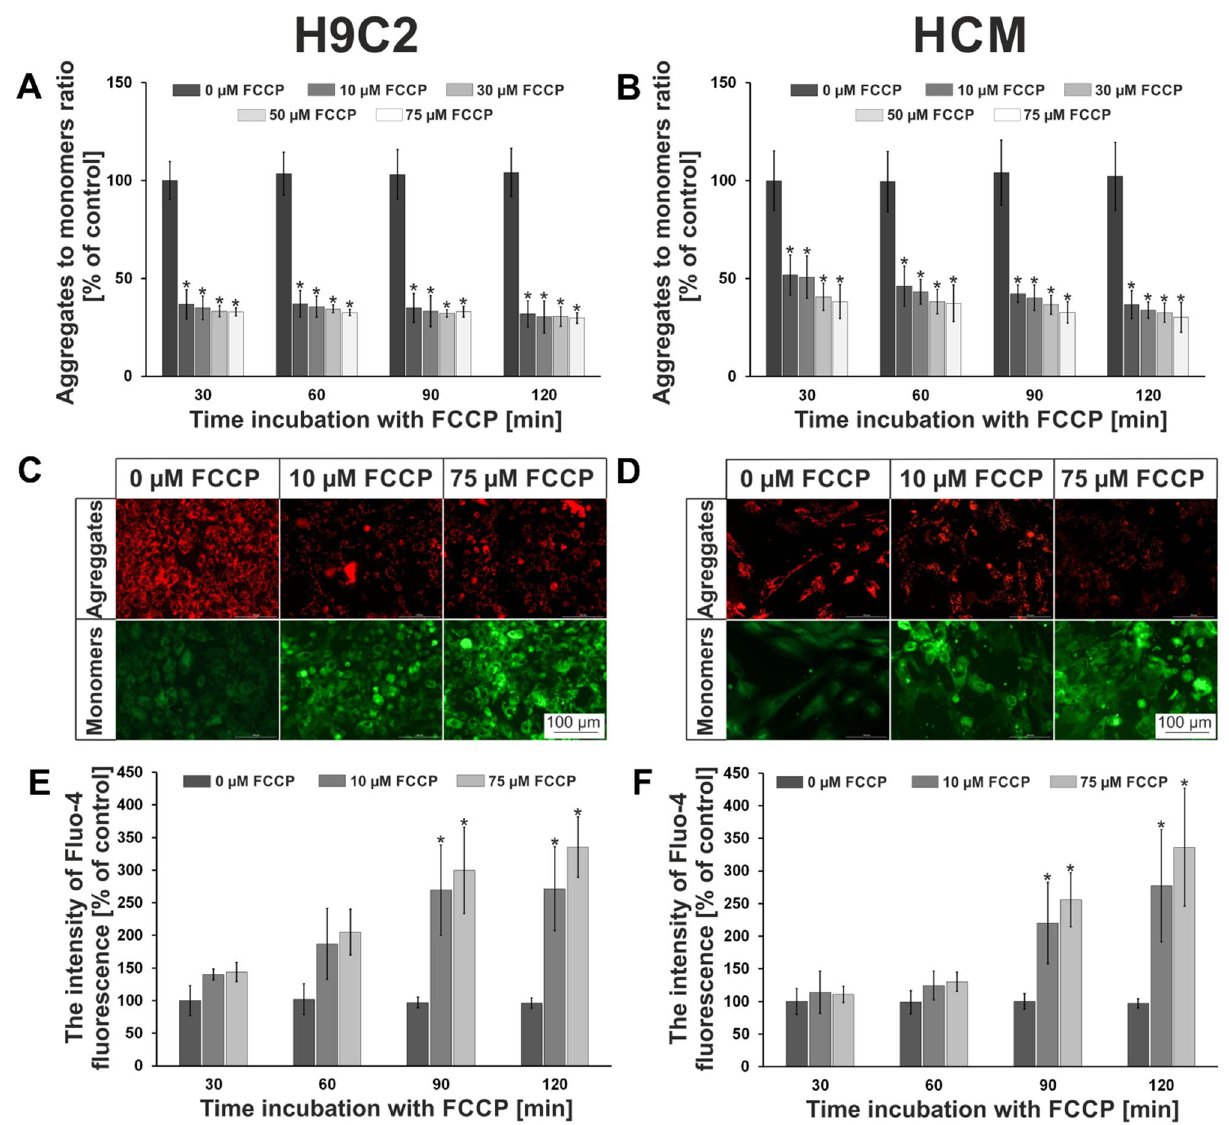
Figure 3. The macroscale results of hypoxia optimization. The results obtained in tests on changes in mitochondrial membrane potential for ( A ) H9C2 and ( B ) HCM cell lines. ( C ) H9C2 cells and ( D ) HCM cells after 120 min incubation with FCCP. Both cell lines were stained with JC-1. The results obtained in tests on changes in concentration of intracellular calcium ions for ( E ) H9C2 and ( F ) HCM cell lines. N ≥ 3, asterisks indicate p <